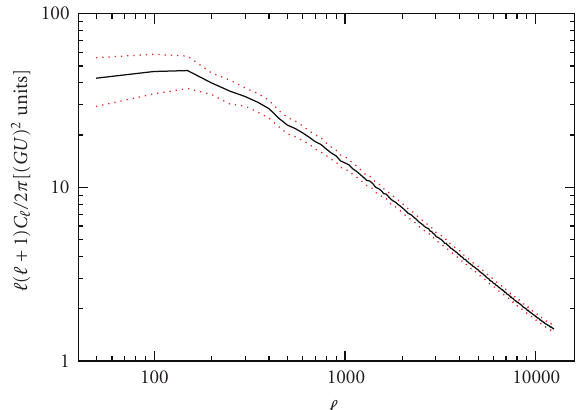
Figure 16: Mean angular power spectrum of the string-induced CMB anisotropies at small angular scales and its one sigma statistical errors (averaged over 300 maps). At “small” multipoles (cid:15) < 500, Doppler contributions from the last scattering surface are expected to be significant and this plot gives only the ISW component